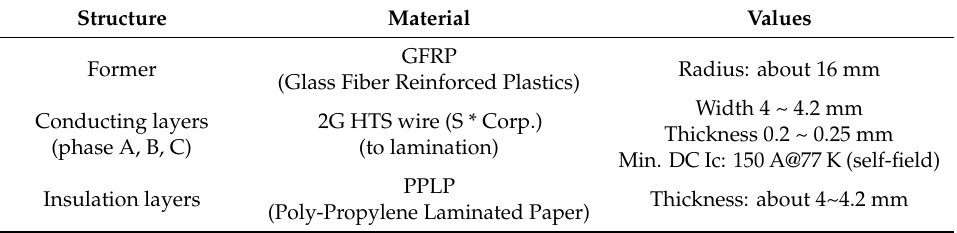
Figure 1. Structure of the 6-m-long, tri-axial high-temperature superconducting (HTS) power cable. Table 1. Structures of the prototype tri-axial HTS power cable model.